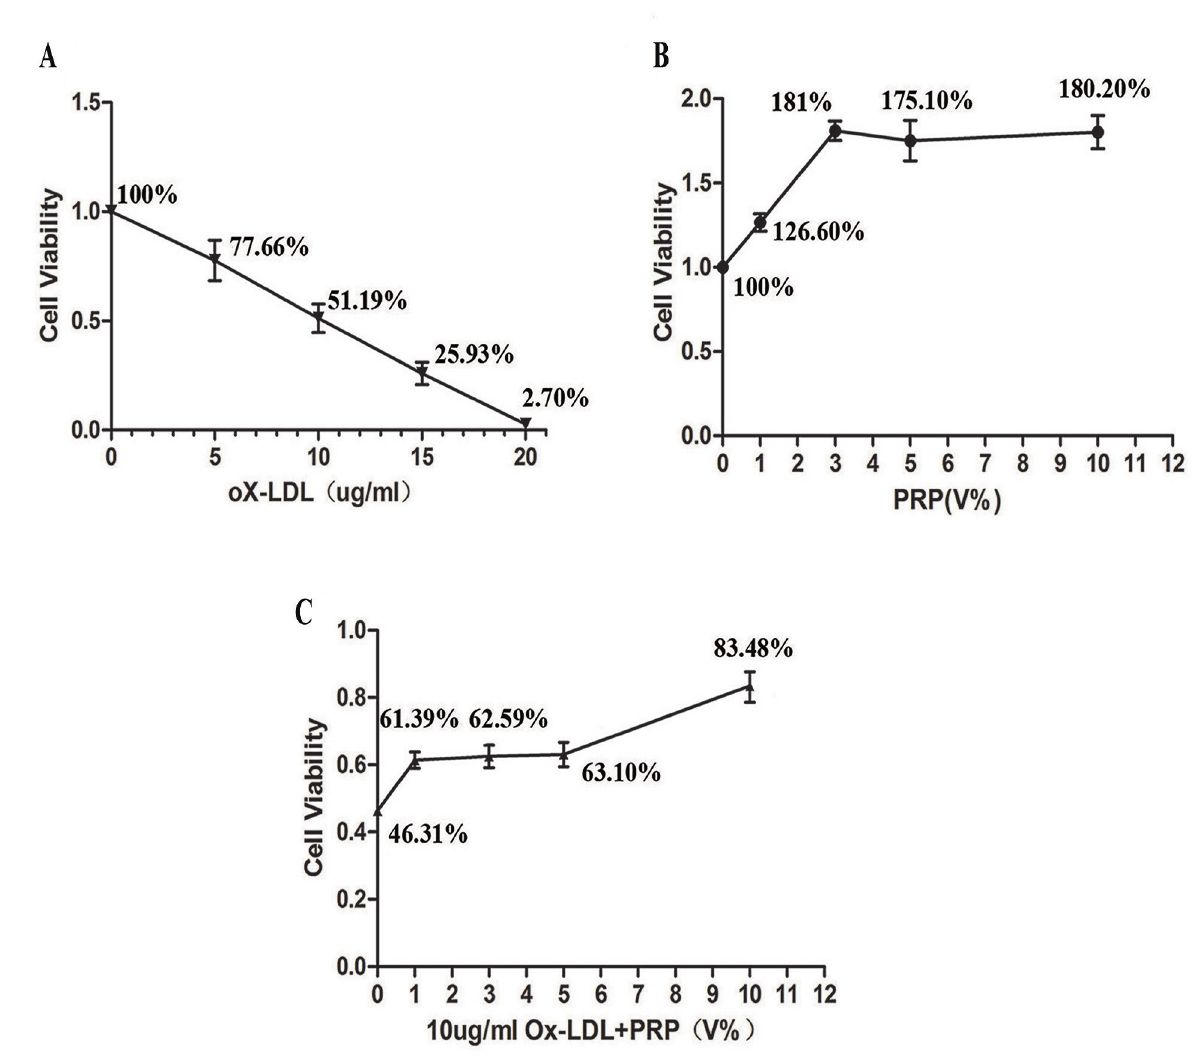
Figure 1: The protective effects of PRP against oX-LDL-induced toxicity (mean ± SD). A: HUVECs were treated with increasing oX-LDL concen- trations. B: HUVECs were treated with PRP in gradient concentrations. C: HUVECs were pre-treated with 3% (V/V) PRP before treatment with